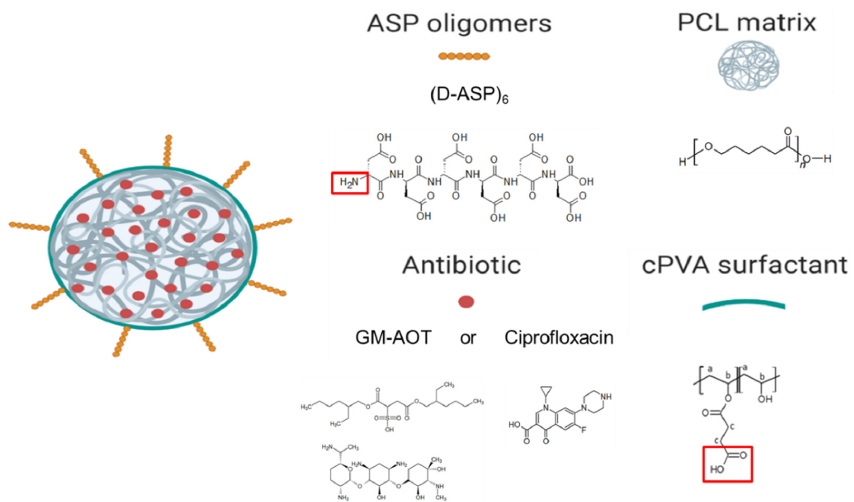
Figure 1. Schematic of PCL/cPVA-ASP microspheres loaded with antibiotic. PCL was used as a biodegradable material for the matrix of the microspheres. The antibiotic CF and the ion-counter ion complex GM-AOT were embedded in the PCL microspheres. ASP oligomers are conjugated to the primary amine group of the N -terminus of ASP (both boxed in